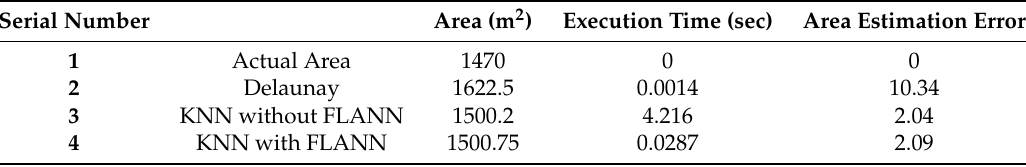
Table 2. Regular Shape